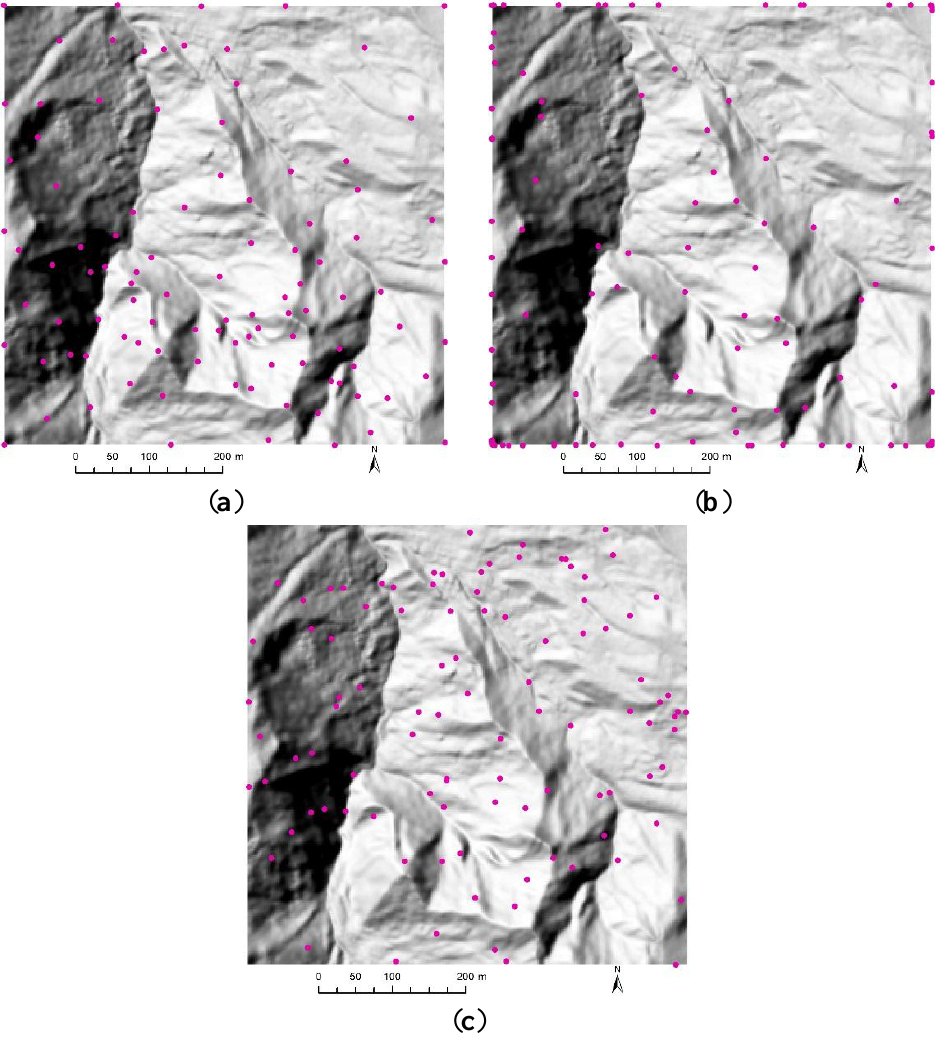
Figure 3. Distribution of the 100 critical points selected by ( a ) TPS-based algorithm, ( b ) max-Z and ( c ) the random method in the undulating terrain.